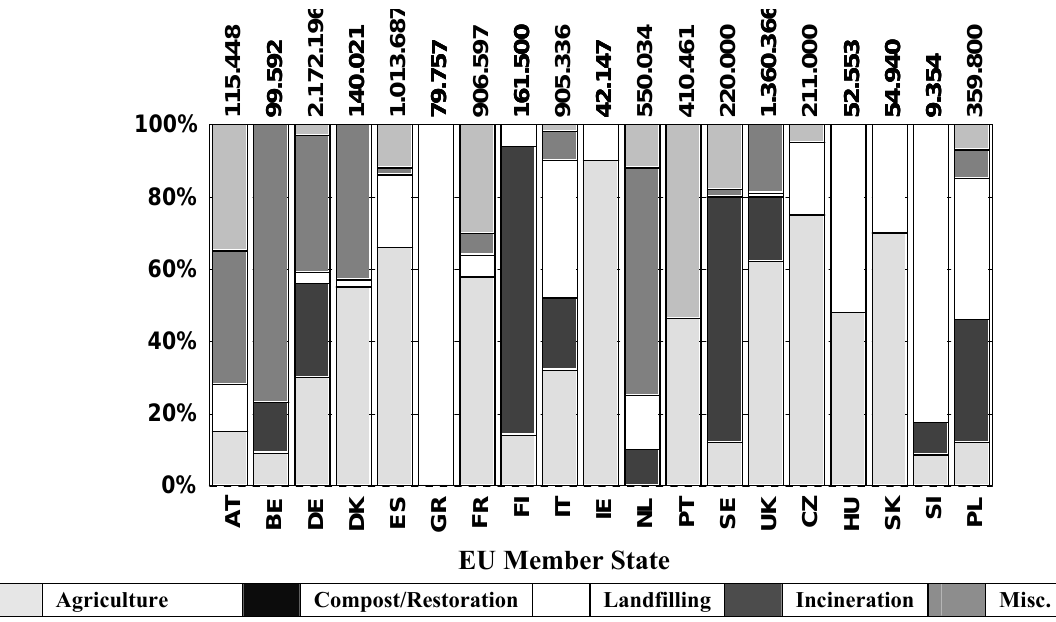
Figure 26: Sewage sludge amount and disposal in the EU The predominant disposal ways in the individual member states show great differences. Whereas in Greece (GR) e.g. the totally generated sewage sludge is landfilled the sewage sludge from Great Britain (UK) is directed into intensive material recovery in agriculture or in landscaping. If the total amount of sewage sludge generated in the EU is classified in the different disposal ways a yield of material recovery of nearly 60 % is given. This corresponds to the material recovery portion in Germany, as the following figure